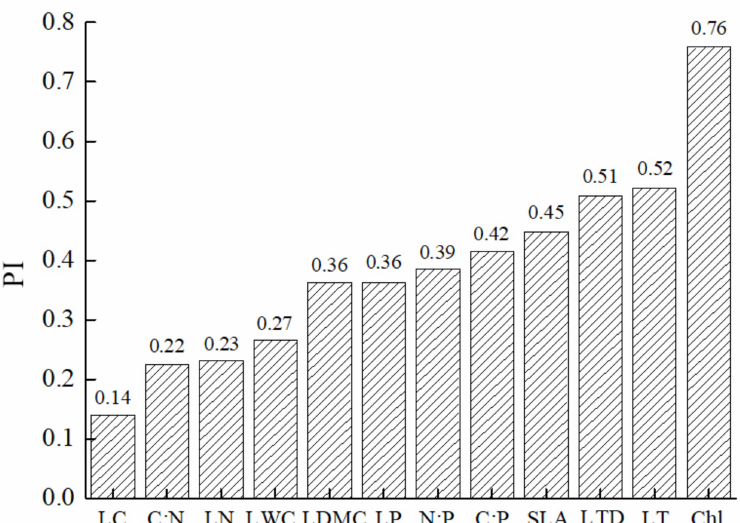
Figure 3. Plasticity index of the leaf functional traits of Z. planispinum . LT, leaf thickness; SLA, specific leaf area; LDMC, leaf dry-matter content; LWC, leaf water content; Chl, chlorophyll; LTD, leaf tissue density; LC, leaf carbon content; LN, leaf nitrogen content; LP, leaf phosphorus content; C:N, leaf C:N ratio; C:P, leaf C:P ratio; N:P, leaf N:P ratio.